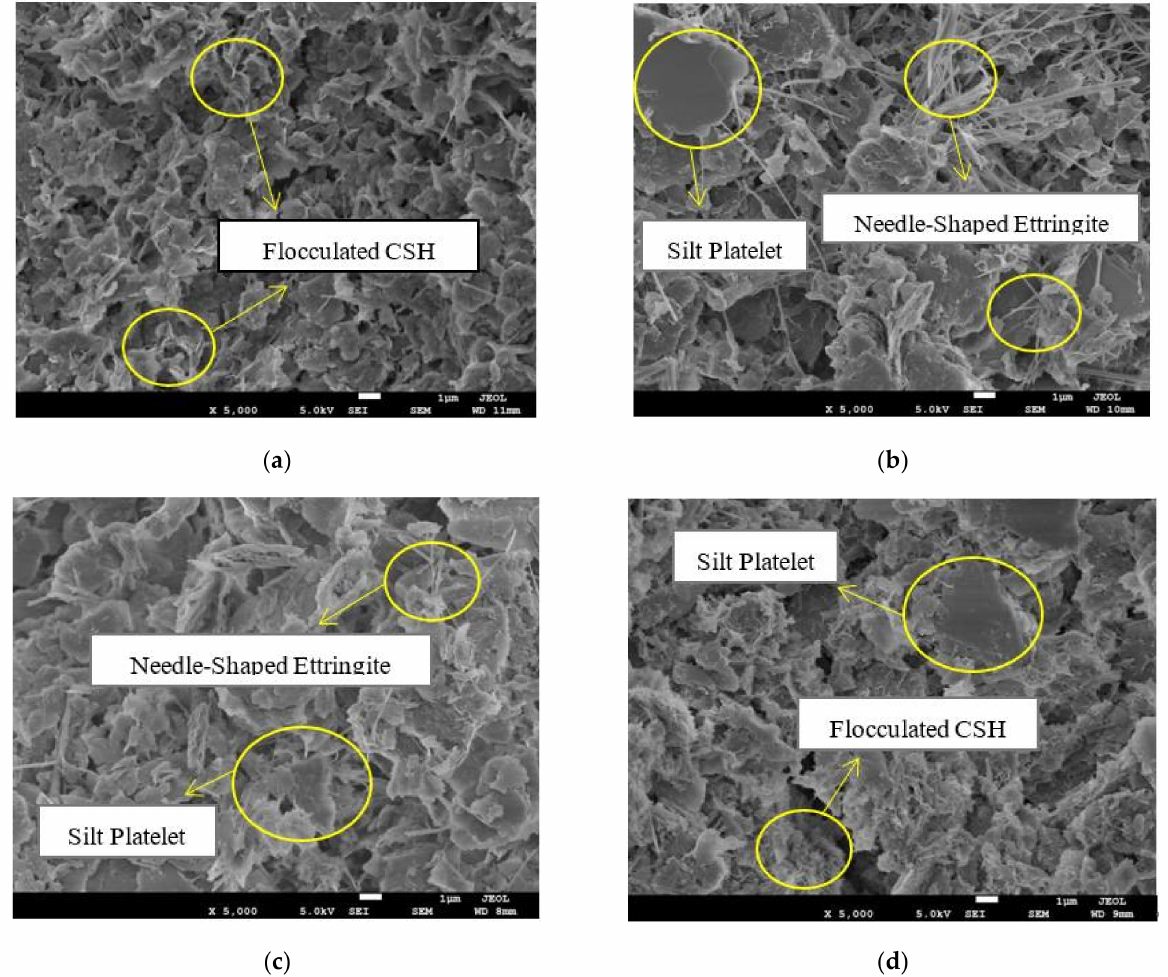
Figure 13. SEM images of specimen treated by 20% cement with different silt contents: ( a ) S1 + 20% cement, ( b ) S2 + 20% cement,